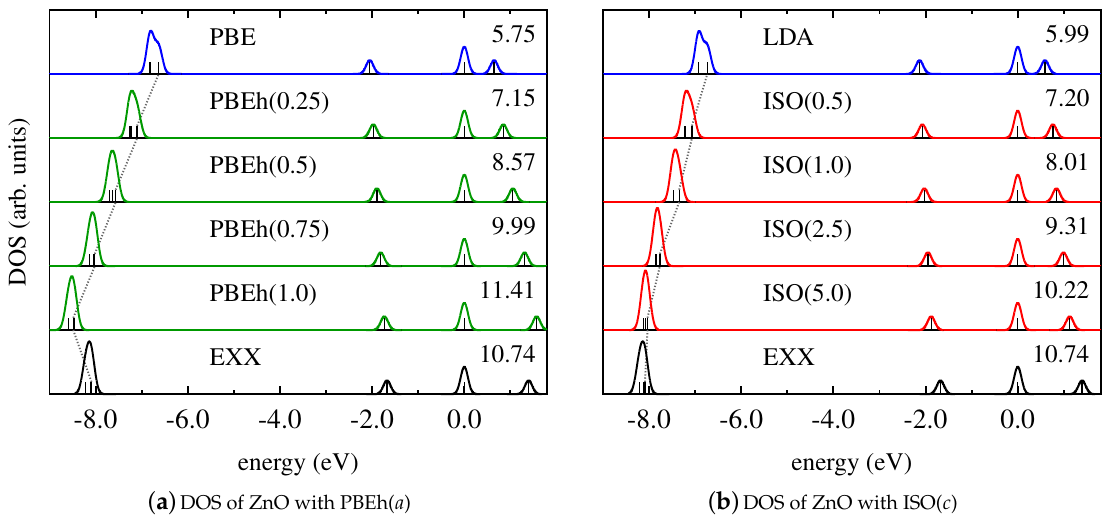
Figure 1. Kohn–Sham density of states (DOS) of ZnO obtained with ( a ) PBE (blue), exact-exchange (EXX, black), and PBEh in dependence on a (green); ( b ) LDA (blue), EXX (black), and ISO in dependence on c (red). In this and all following figures, each panel contains the value of − ε ho in eV in order to indicate the absolute position of the DOS on the energy scale. Further, the relative shift of the d -states—which were identified in DARSEC as the Kohn–Sham states with angular momentum quantum number m = ± 2 (cf. Reference [107])—is highlighted by the dashed grey